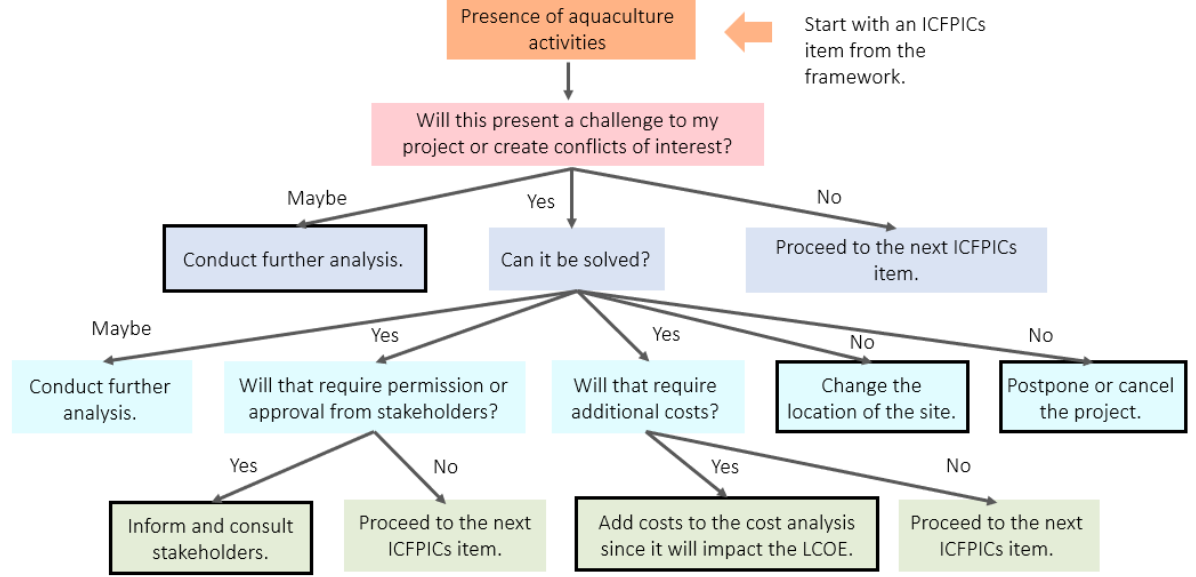
Figure 2. Integrative conceptual framework for harnessing wave energy in the PICs (ICFPICs).